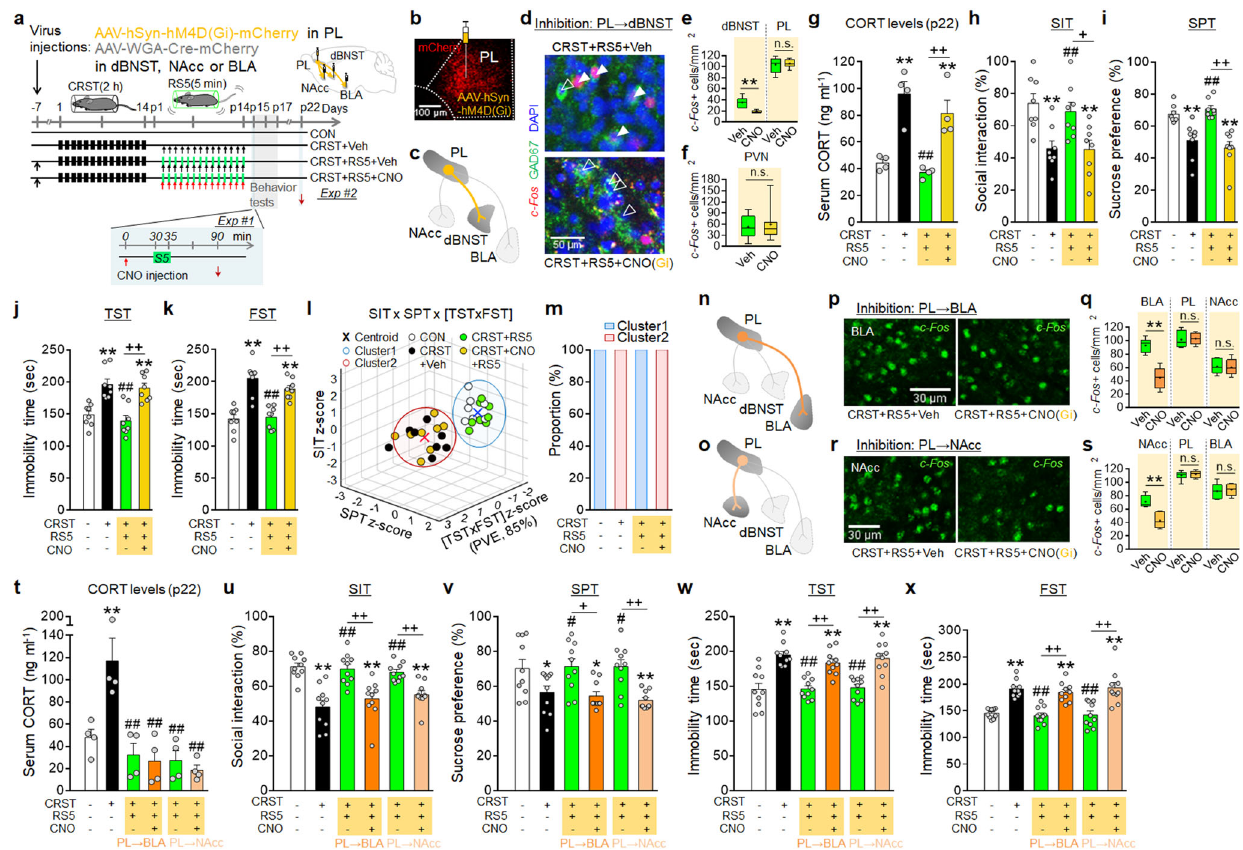
Fig. 9 Chemogenetic inhibition of PL neurons projecting to the dBNST, BLA, or NAcc blocks the anti-depressive effects of RS5. a Experimental design. AAV8-hSyn-hM4D(Gi)-mCherry injection into the PL and a retrograde Cre vector injection into the dBNST, BLA, or NAcc. Mice were then subjected to CRST, followed by RS5 treatment with Veh or CNO injection. b – f mCherry expression by the injected vector in the PL ( b ). Diagram for the PL → dBNST circuit ( c ) labeled with hM4D(Gi) expression. Immuno fl uorescence staining of c-Fos (red) and GAD67 (green) in the dBNST ( d ) of the indicated groups. Quanti fi cation of RS5-induced c-Fos expression in the dBNST, PL ( e ), and PVN ( f ) after CNO injection (Exp #1) ( n = 4 per group). DAPI, blue. g – m Basal CORT levels ( g ), the % time of social interaction in the SIT ( h ), the % sucrose-preference in the SPT ( i ), and immobility time in the TST ( j ) and FST ( k ) for the indicated groups (Exp #2). K -means clustering of individuals in the SIT × SPT × [TST × FST] matrix ( l ) and the % composition of each group in the clusters ( m ) ( n = 8 animals per group). n – s Diagrams for the PL → BLA ( n ) and PL → NAcc ( o ) circuits labeled with hM4D(Gi) expression. RS5-induced c-Fos expression in the BLA ( p ) and NAcc ( r ) after CNO or Veh injection for the PL → BLA ( p ) and PL → NAcc ( r ) groups. Quanti fi cation of RS5-induced c-Fos expression levels in BLA, PL, and NAcc ( q ) and NAcc, PL, and BLA ( s ) after CNO injection for the indicated groups (Exp #1) ( n = 3 – 4 animals per group). t – x Basal CORT levels ( t ), the % time of social interaction in the SIT ( u ), the % sucrose-preference in the SPT ( v ), and immobility time in the TST ( w ) and FST ( x ) for the indicated groups (Exp #2) ( n = 10 animals per group). Data were mean ± SEM. *, the difference compared to control; #, the difference compared to CRST. *, #, p < 0.05; **, ##, p < 0.01 (Two-sided Student ’ s t -test; one-way ANOVA followed by Newman – Keuls post hoc test). n.s. not signi fi cant. See Supplementary Data 4 for statistical